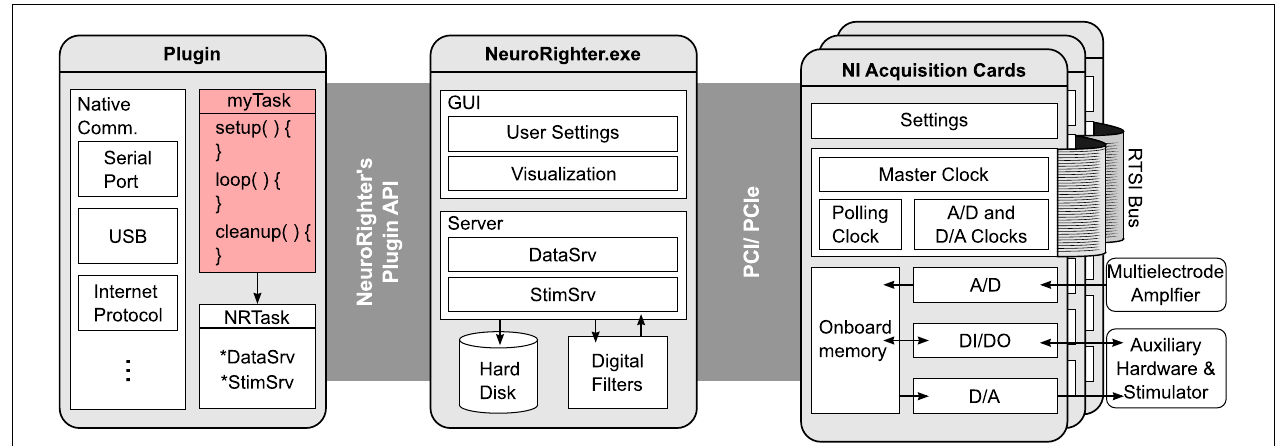
from the acquisition cards’ FIFO memory to RAM using direct memory access. Data is then pushed to NeuroRighter’s DataSrv server object. DataSrv serves data to NeuroRighter’s visualization tools, filtering algorithms, and externally compiled plugins.The plugin API provides functions for safe interaction with DataSrv so that custom operations can be performed on incoming data streams. User-written plugins can interact with any of the computer’s native communication ports, or write data back to StimSrv in order to control external hardware as a function of recorded neural